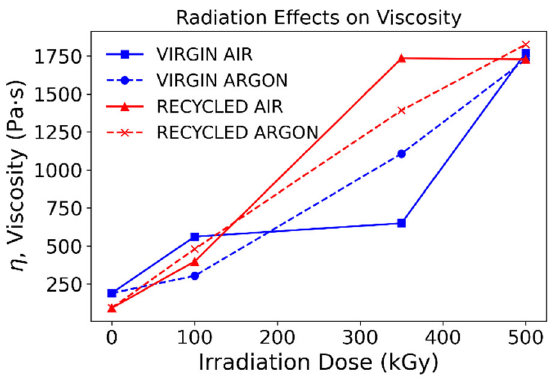
Figure 2. Radiation effects on viscosity.